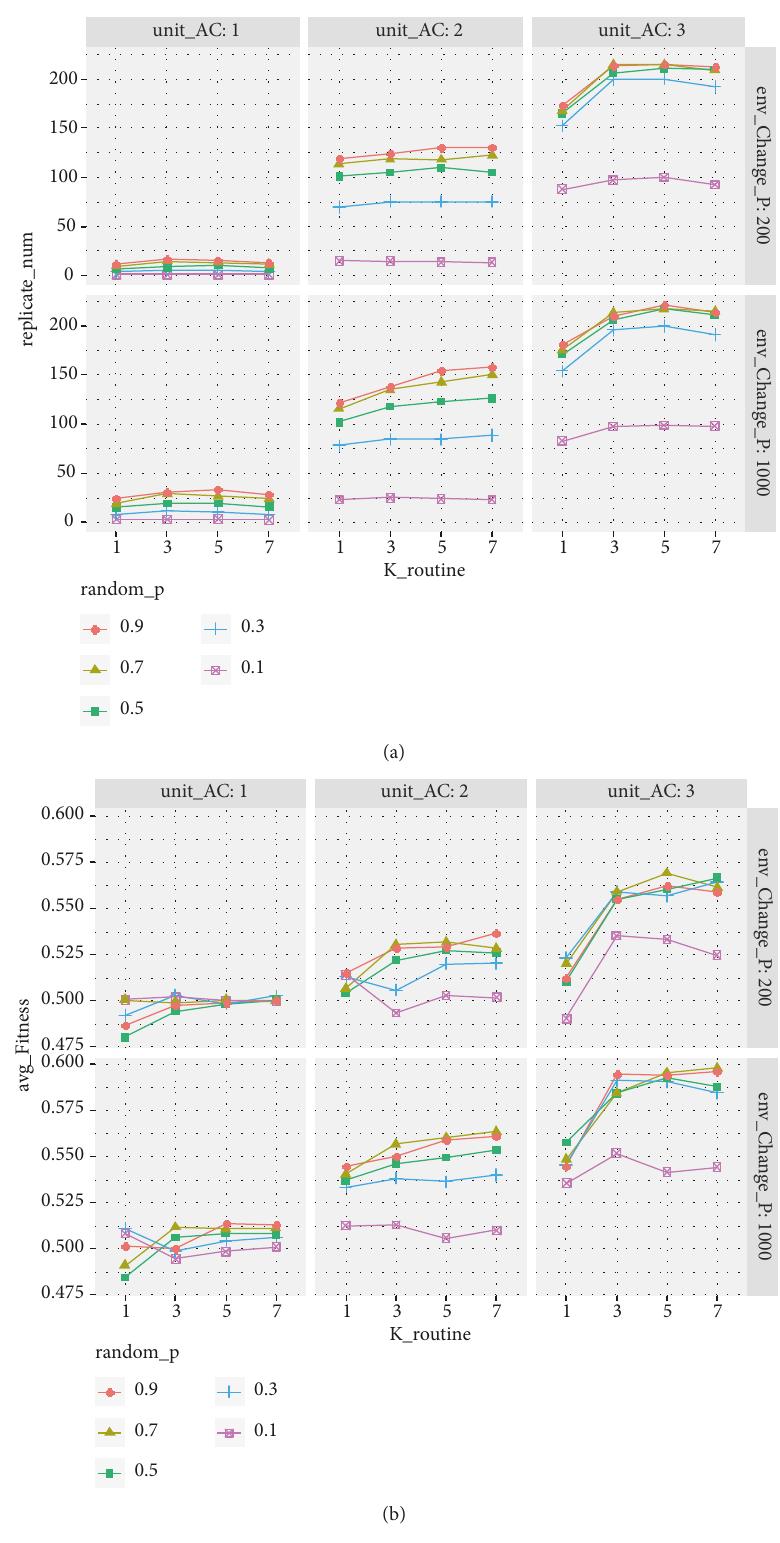
Figure 8: Simulation results in dynamic environments (Scenario III): (a) replicate num values; (b) avg Fitness